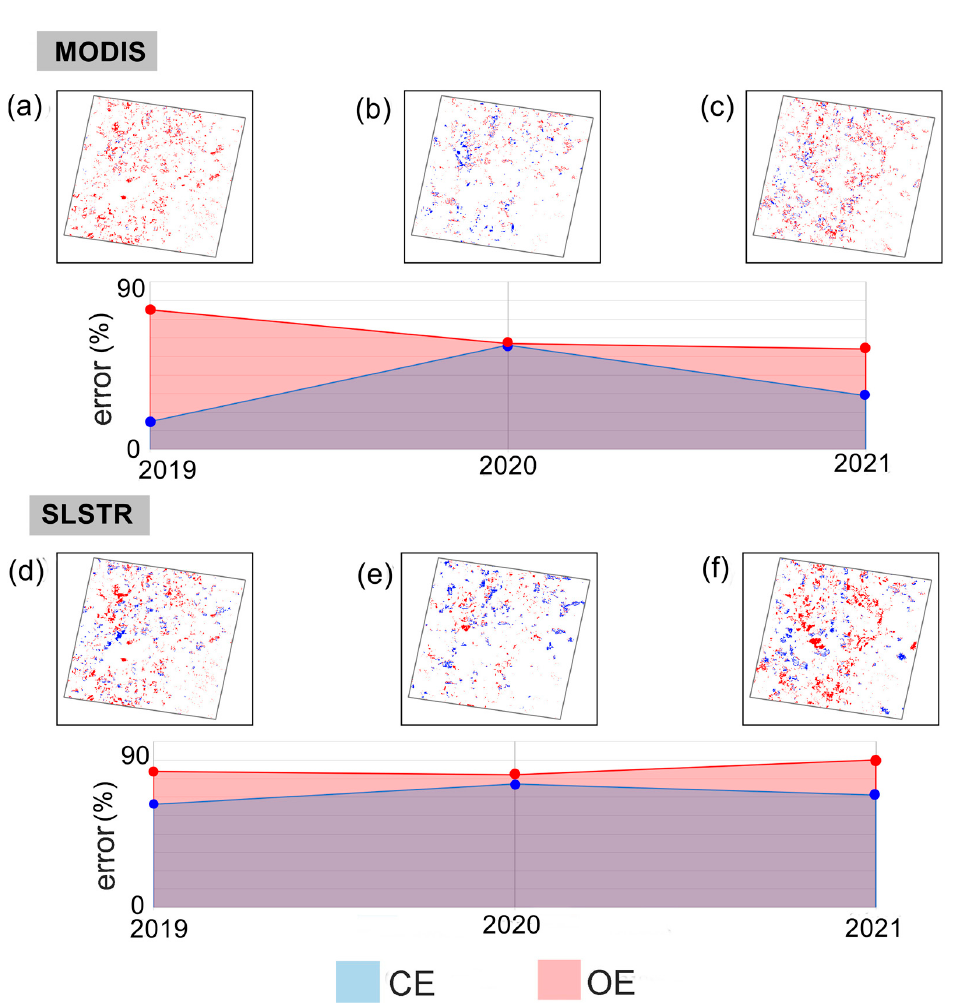
Figure 5. Spatial distribution of OE and CE for the burned area maps generated by the SVM classifier in the SLSTR and MODIS images for years 2019 ( a , d ), 2020 ( b , e ), and 2021 ( c , f ). Table 3. Data Coefficient (DC) Values after validation of MODIS and SLSTR burned area maps.